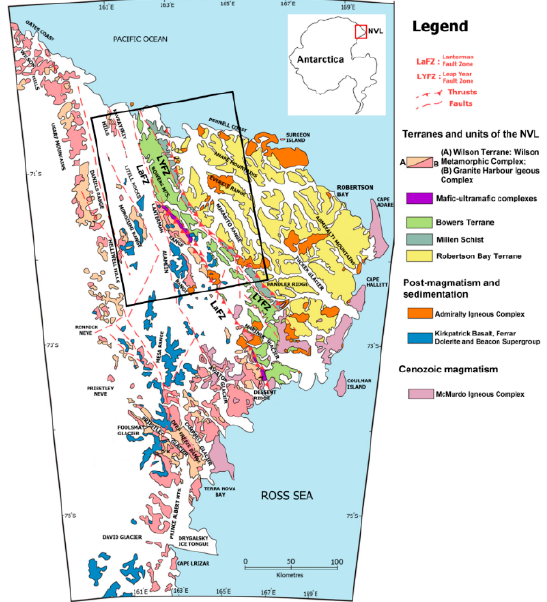
Figure 1. Geological map of Northern Victoria Land (NVL). Modified from [7,48] based on the GIGAMAP series [52]. The black rectangle shows the coverage of ASTER images used in this study.